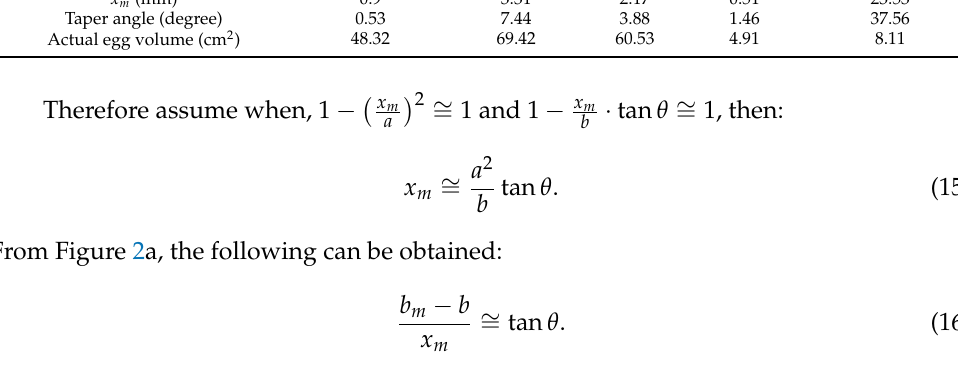
Table 1. Egg shape geometry parameters. Egg length ( L )